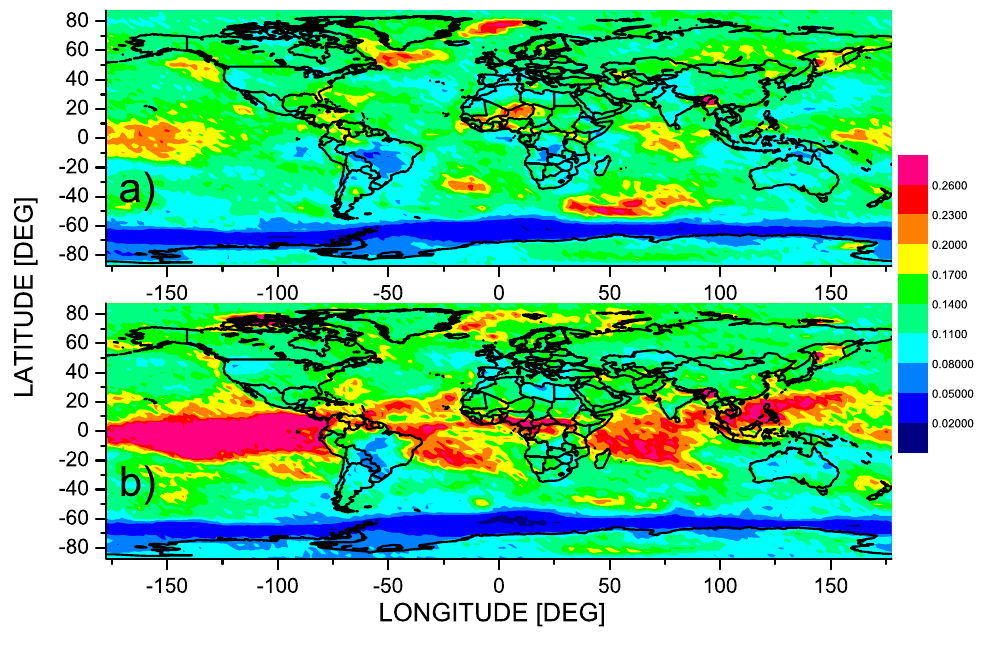
Fig. 9. Mean absolute correlations of SATA with their independent univariate FT surrogate data for negative (a) and positive (b) ENSO